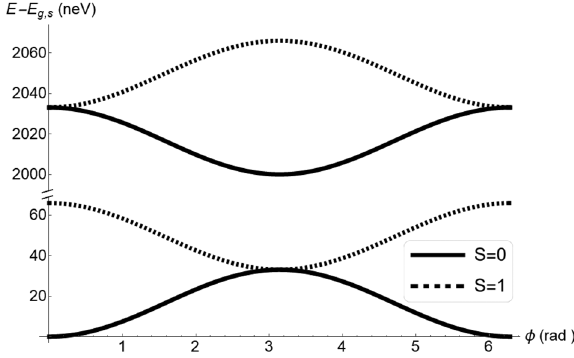
Fig. 3 Low-energy spectrum of a two-electron Si DQD. Energy levels of the ground and fi rst excited singlet ( S = 0) and triplet states ( S = 1) in a Si double dot as a function of the interdot valley phase difference ϕ . For this calculation we choose Δ R = 1 μ eV, Δ L = 100 μ eV, and ϕ R =